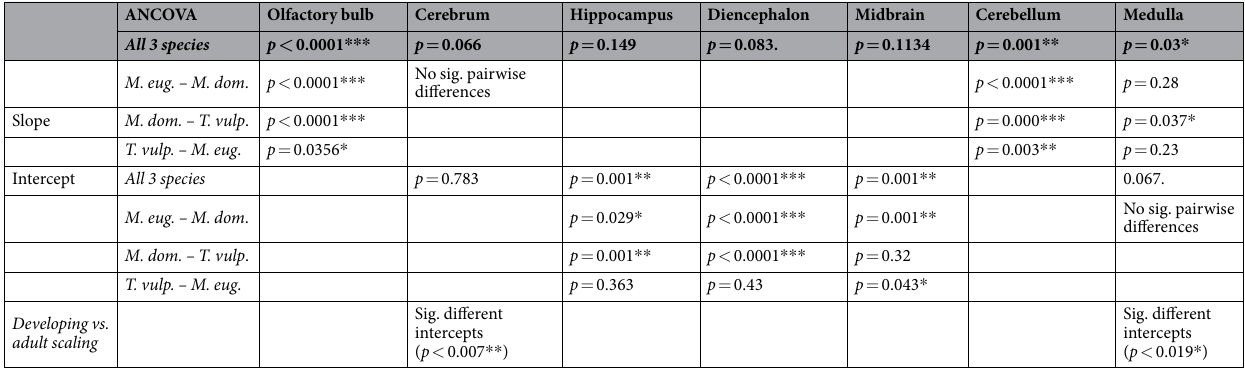
Table 2. ANCOVA results for partition volume growth patterns against whole brain minus partition volume. Significant p -values ( p < 0.05) are indicated with asterisks. When the overall ANCOVA did not reveal significant differences, no pairwise comparisons were conducted; when a significant interaction (i.e. slope difference) was found, no intercept differences were assessed. M. eug. = Macropus eugenii, T. vulp. = Trichosurus vulpecula, M. dom. = Monodelphis domestica .